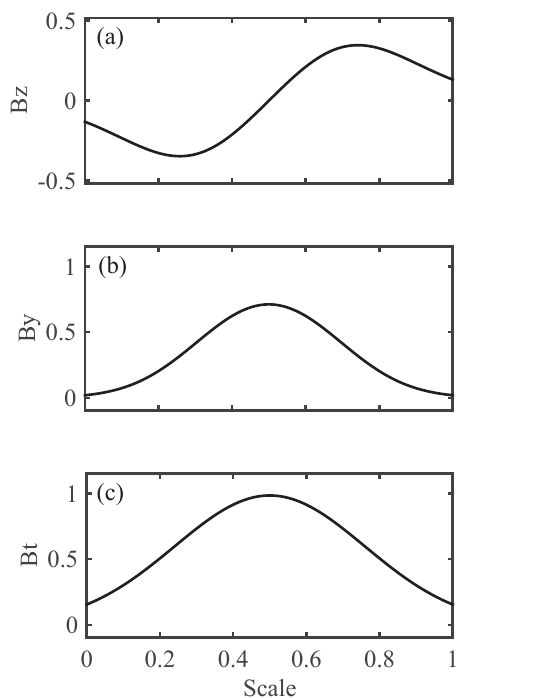
Figure 3. The target-function-to-be-correlated (TFC) derived from E – R model. The amplitudes and scale are